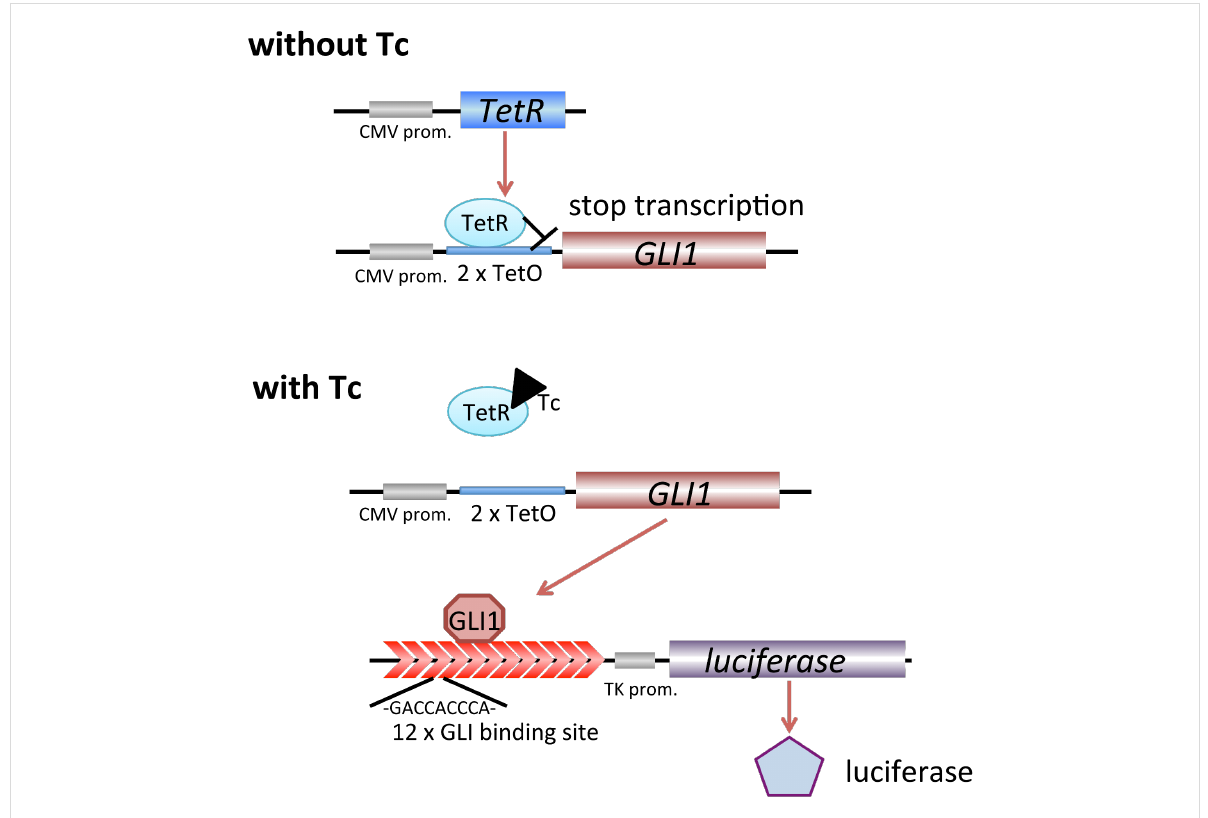
Figure 1: Schematic procedure of the constructed assay system; Tc (tetracycline), TetR (tetracycline repressor), TetO (tetracycline